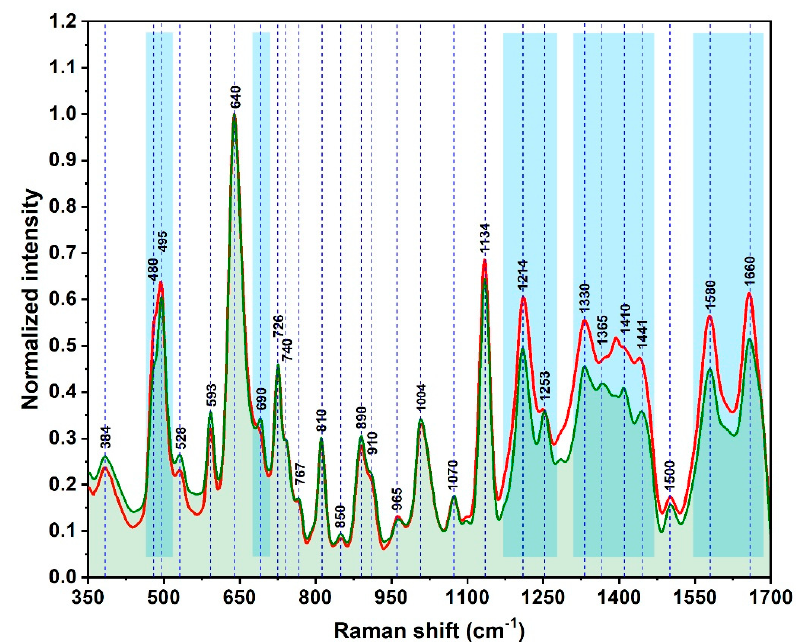
Figure 6. Overlapping of the mean SER spectra recorded on the blood plasma samples collected from healthy subjects (green spectrum) and BC patients (red spectrum) recorded on SSPSs using a 785 nm excitation laser. The spectra were normalized to the 640 cm − 1 peak.